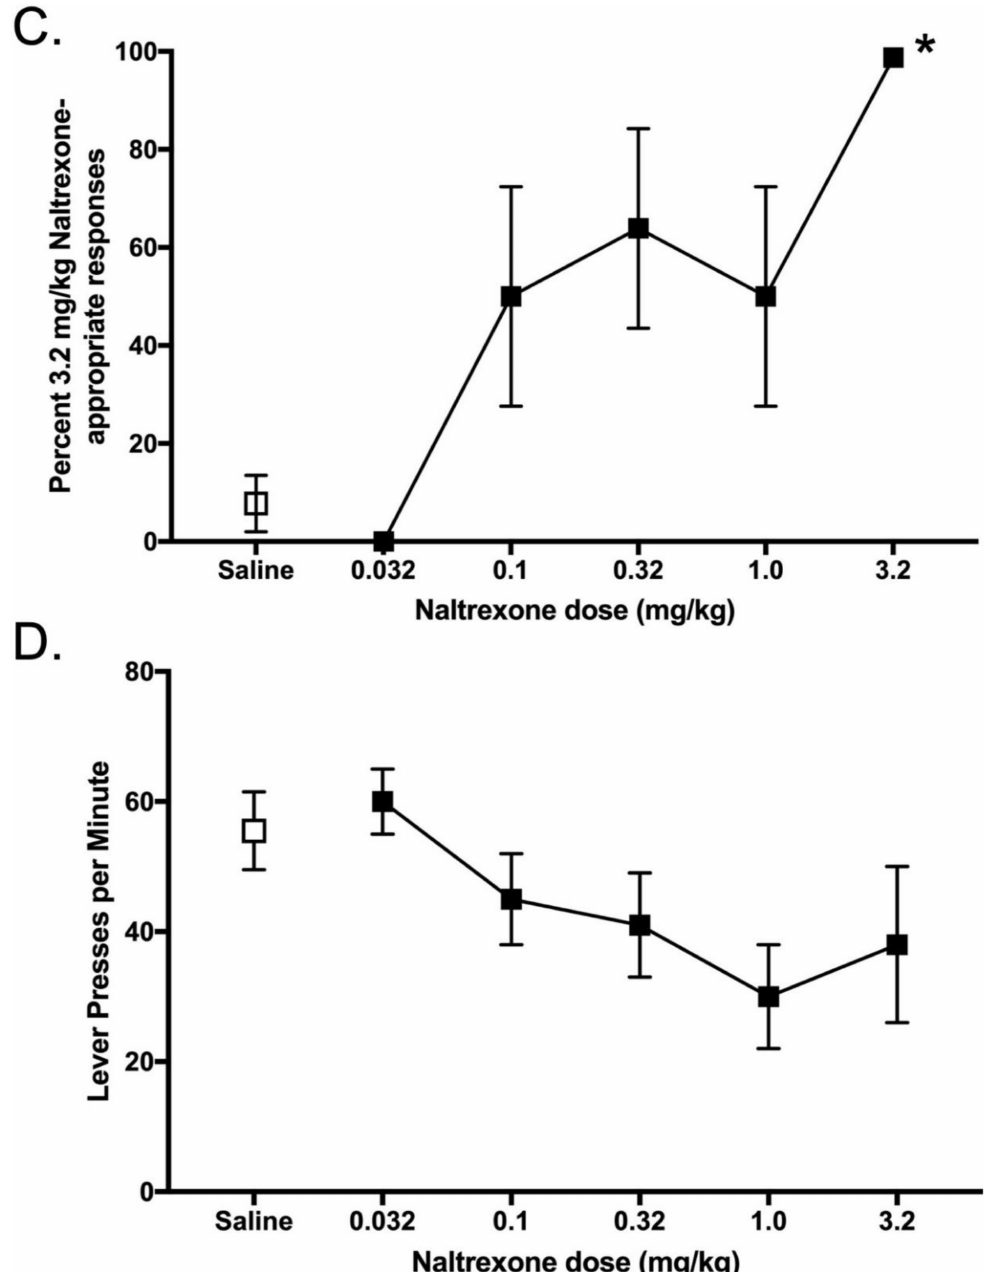
Figure 4. Effect of acute water substitution on NTX generalization functions (saline, open squares and NTX, filled squares) in rats trained to discriminate 3.2 mg/kg NTX from saline. ( A ) NTX generalization function and ( B ) responses rates in rats with chronic intermittent 25% sucrose solution given 1 h before the test. ( C ) NTX generalization function and ( D ) responses rates in rats with water given 1 h before the test. * = p < 0.05 (significantly different than saline